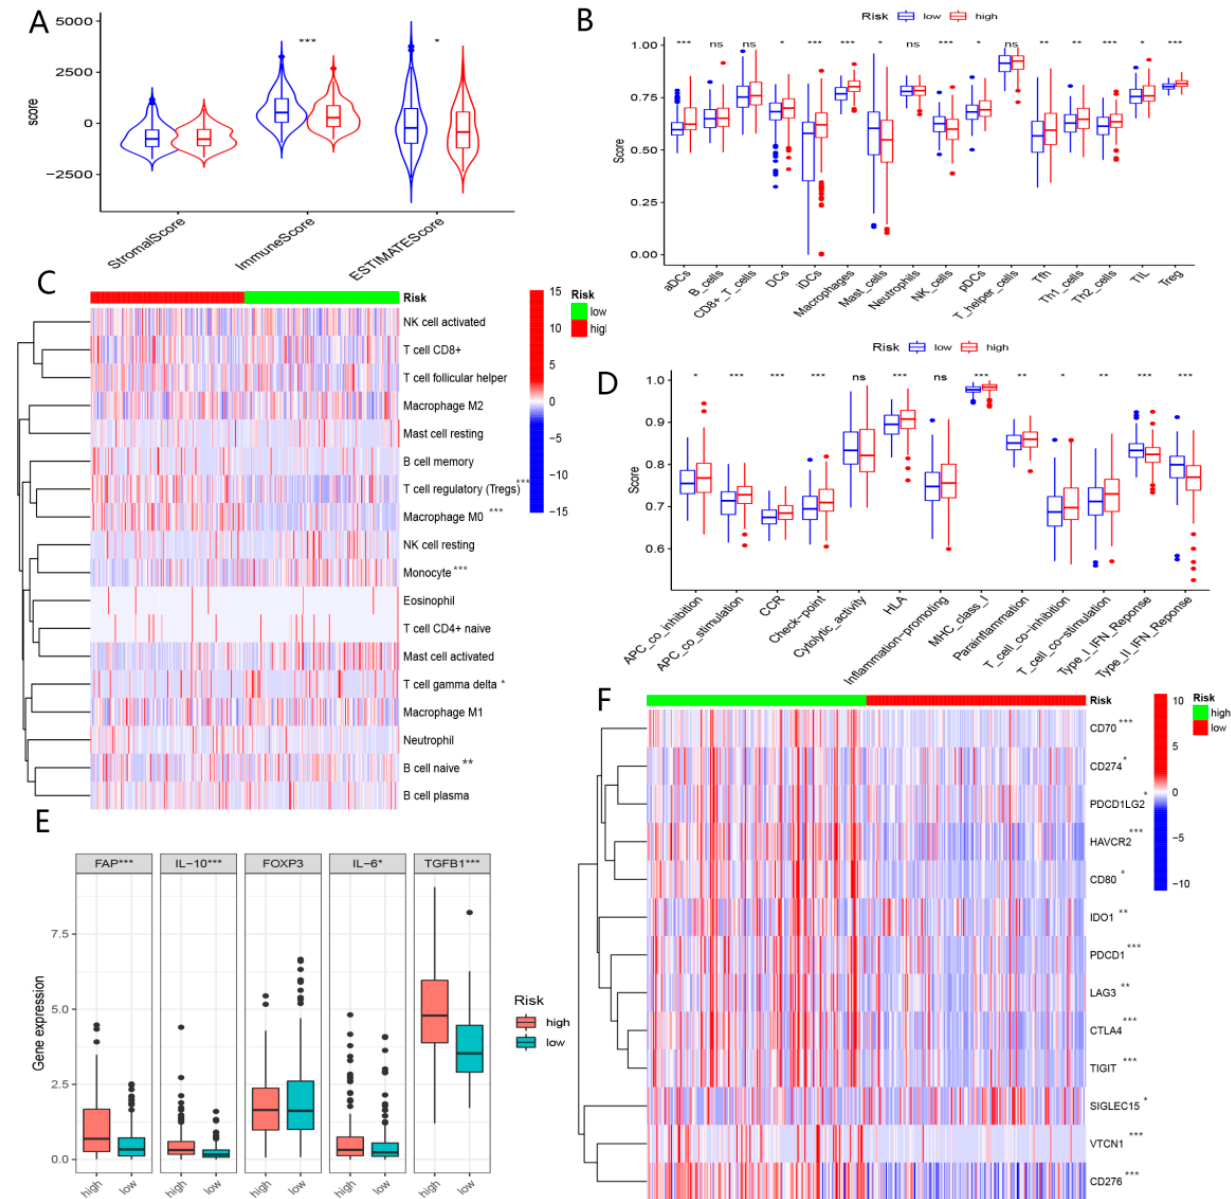
Figure 13. The role of BMGs in immune profiles. ( A ) Comparison of the immune microenvironment of tumors in low- and high-risk groups with the ESTIMATE algorithm. ( B ) Comparison of immune cells in low- and high-risk groups using the ssGESA algorithm. ( C ) Comparison of immune cells in low- and high-risk groups using the CIBERSORT algorithm. ( D ) Comparison of immune functions in low- and high-risk groups using the ssGESA algorithm. ( E ) Comparison of expression level of Immunosuppression-related genes in low- and high-risk groups. ( F ) Comparison of the expression level of common immune checkpoint in low- and high-risk groups. (“*”, “**”, “***” represent p < 0.05, p < 0.01, p < 0.001, respectively, ns: not